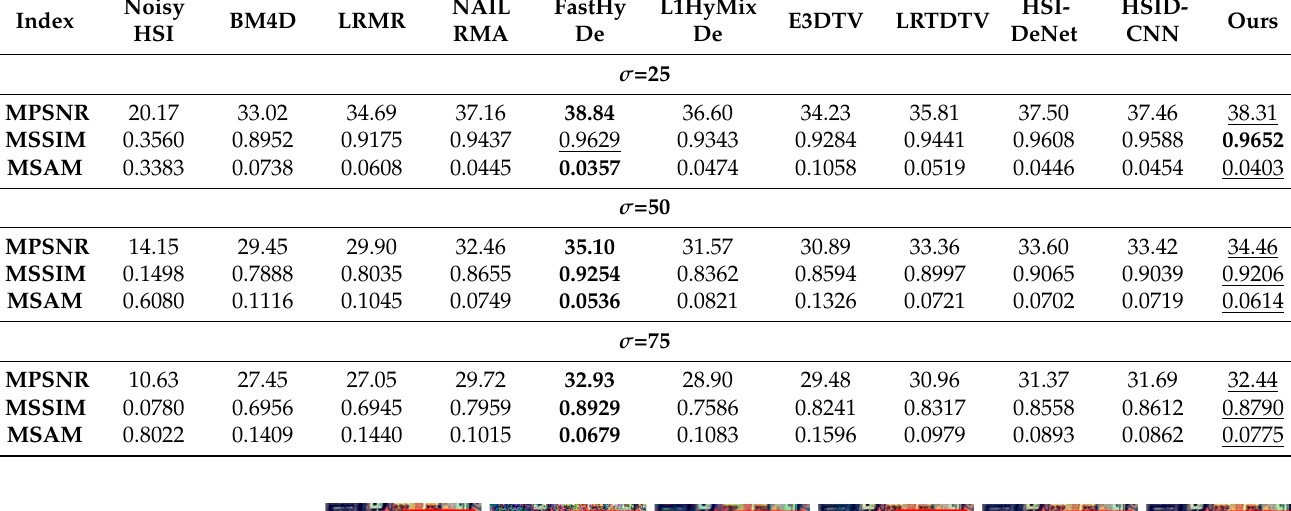
Table 1. Quantitative assessment of different algorithms applied to Washington DC Mall data with Gaussian i.i.d. noise.